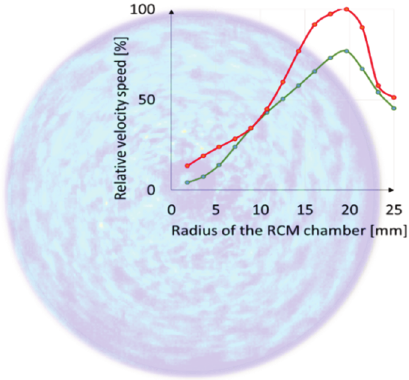
Fig. 18. Relative vortex velocity in a rapid compression machine chamber at CO 2 injection pressure equal to: 6 bar (green), 10 bar (red) The uniformity of the formed ring surrounding the cen- Fig. 16. Gas current lines with CO 2 injection pressure of: a) 6 bar, b) 10 bar of velocity vectors described by the color palette (Fig. 19)